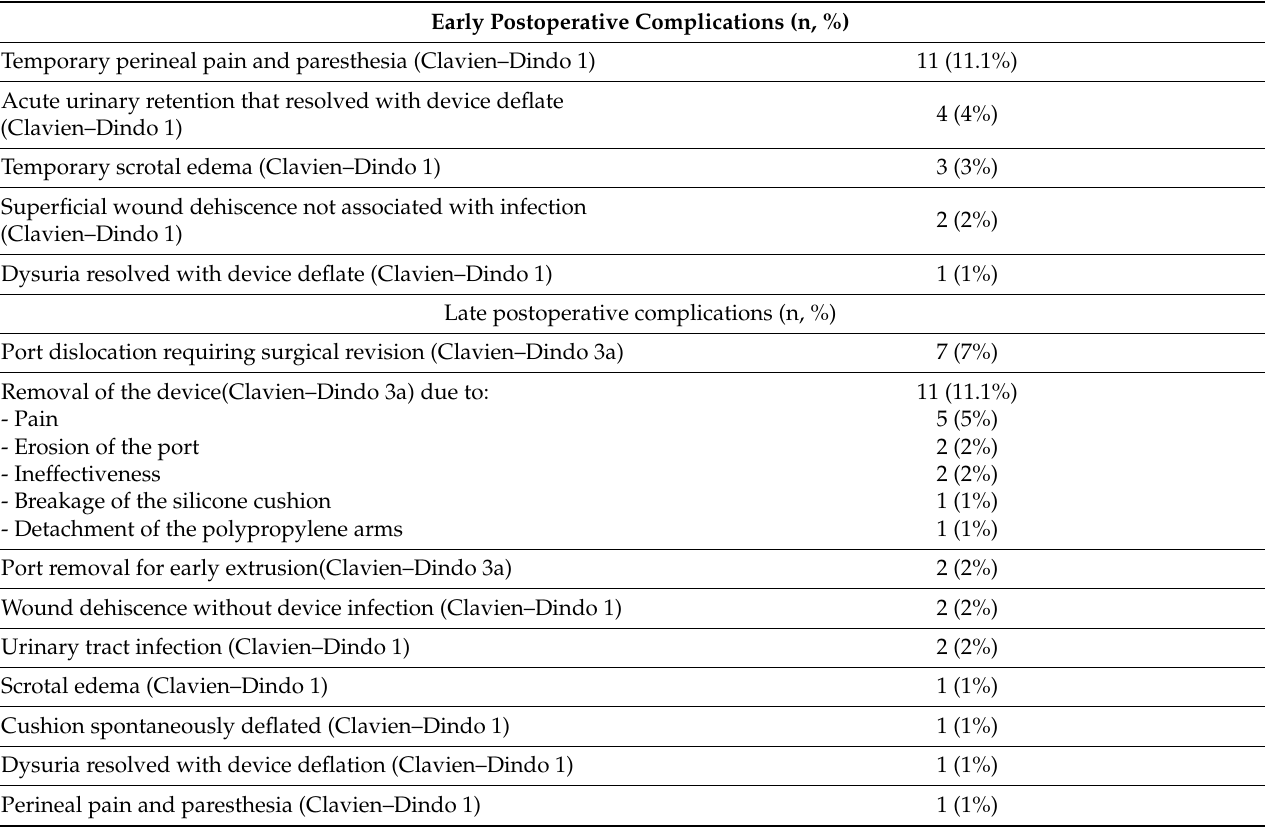
Table 2. Postoperative